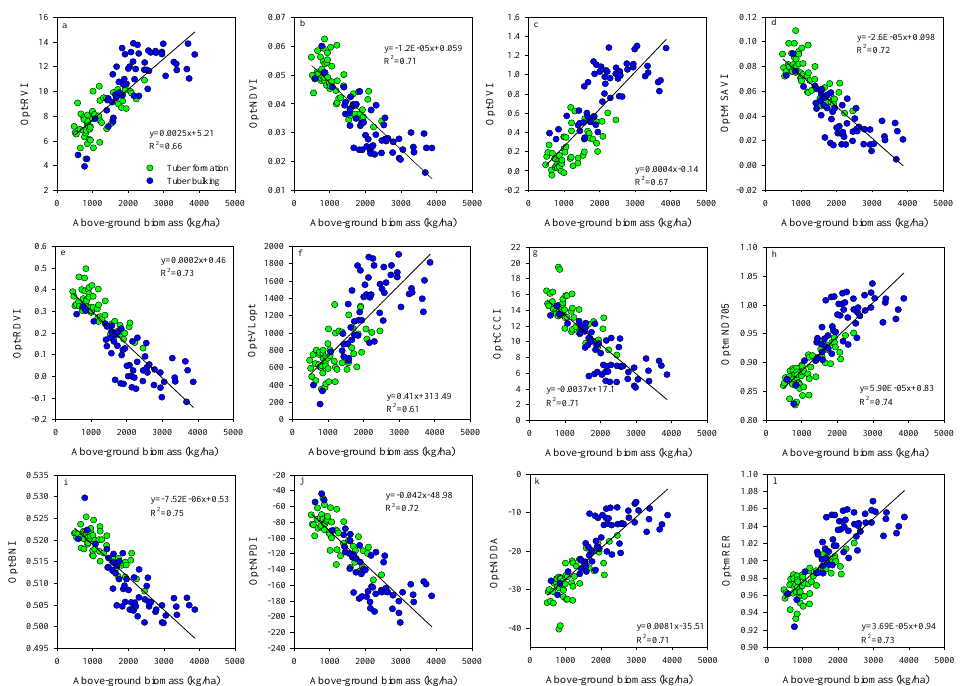
Figure 13. Relationships between potato above-ground biomass and (a) Opt-RVI, (b) Opt-NDVI, (c) Opt-DVI, (d) Opt-MSAVI, (e) Opt-RDVI, (f) Opt-VLopt, (g) Opt-CCCI, (h) Opt-mND705, (i) Opt-BNI, (j) Opt-NPDI (k)Opt-NDDA and (l) Opt-mRER at the combined growth stages.